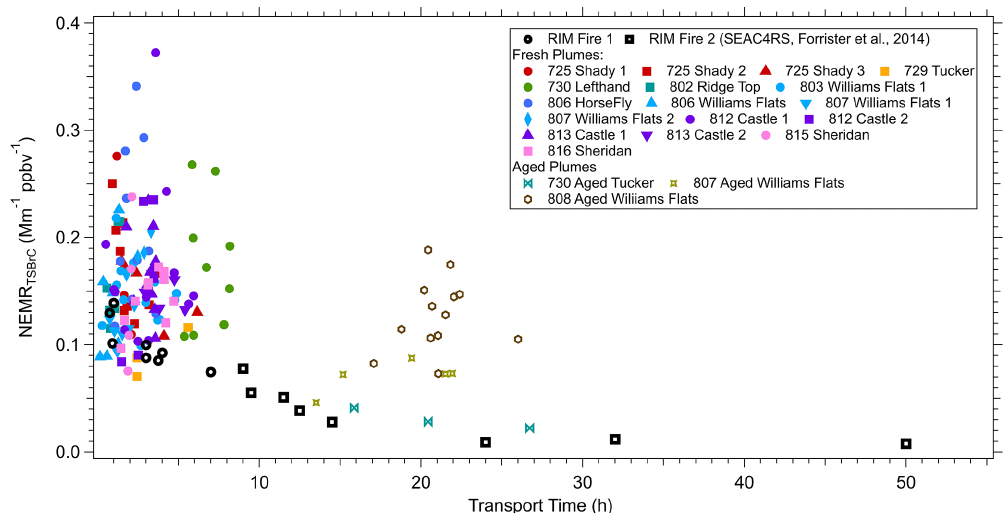
Figure 8. NEMR TSBrC at 365nm measured in liquid extracts (conversion factor K is not applied) versus smoke transport time. Different colors represent different plumes (also see Table 3). Open markers (circles and squares) are data obtained from the RIM fire during the SEAC 4 RS campaign reported by Forrister et al.